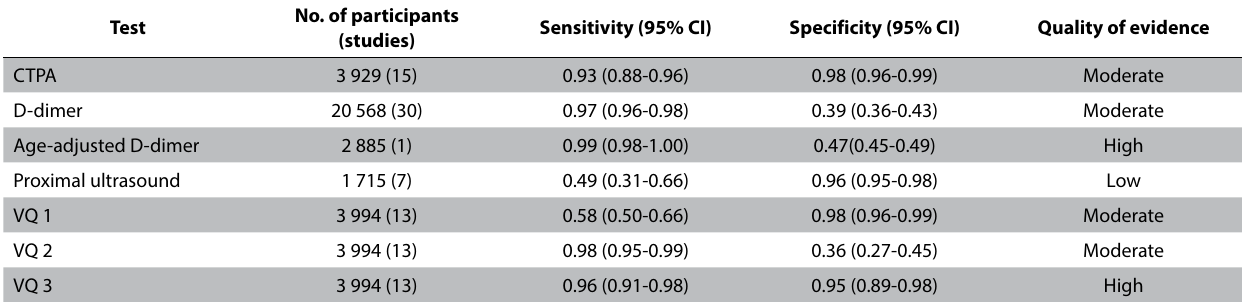
Table 3. Summary of results of studies informing sensitivity and specificity of tests for diagnosis of PE 7